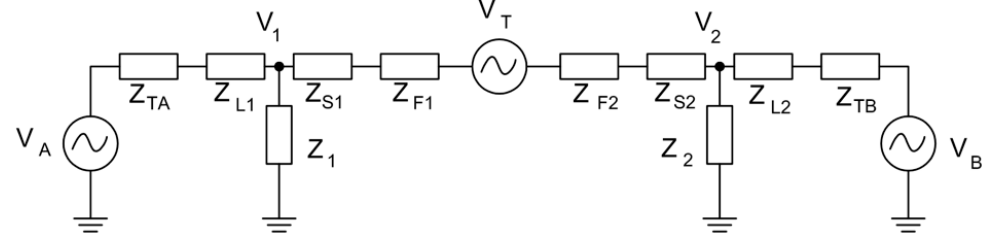
Figure 4. Model considering all system parameters.